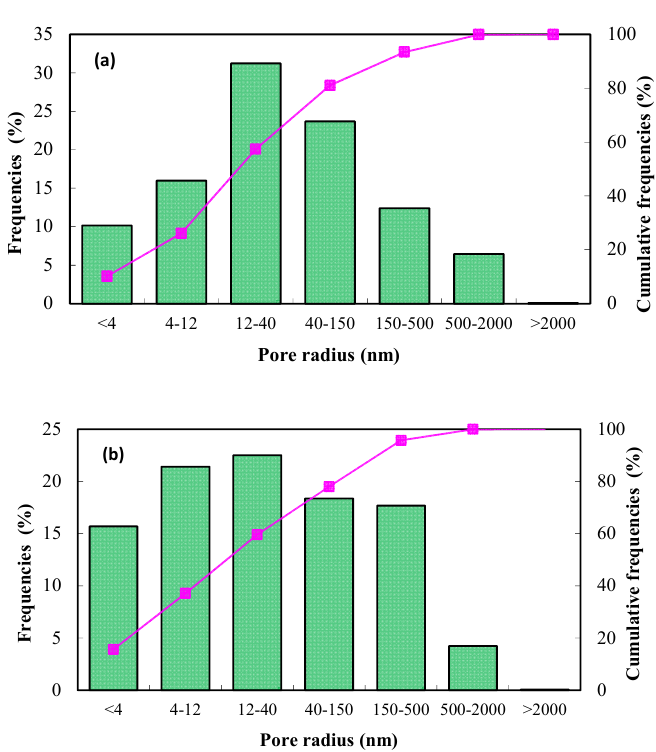
Figure 11. Average pore size distributions estimated by NMR logs: ( a ) Upper sweet spot reservoir; ( b ) Lower sweet spot